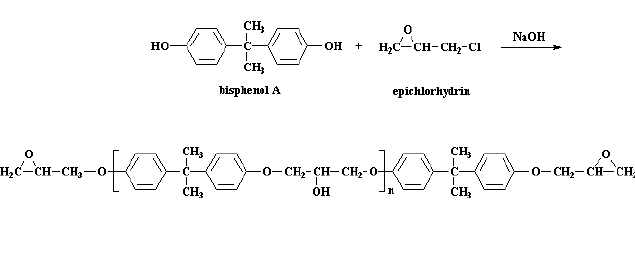
Fig 1. Chemical structure of bisphenol A, epichlorhydrin and epoxy resin The relation between mass ratio of resin and hardener to epoxy polymer qualities has been studied in our previous